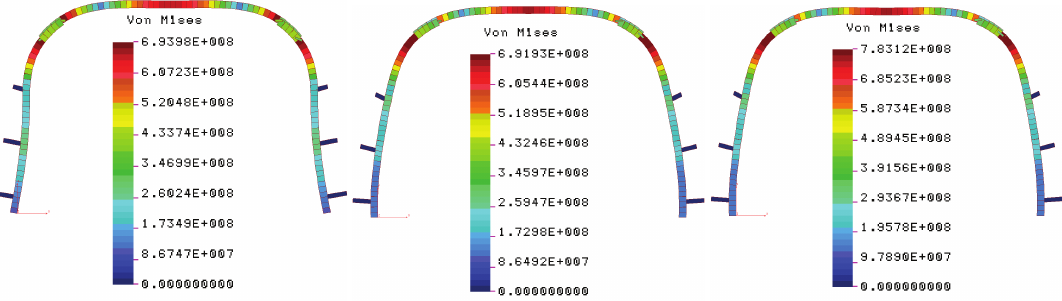
Figure 12: Map of reduced stresses in A (left), B (middle) and C (right) frames for load scheme – variant I (stresses in Pa, deformation scale 10×).